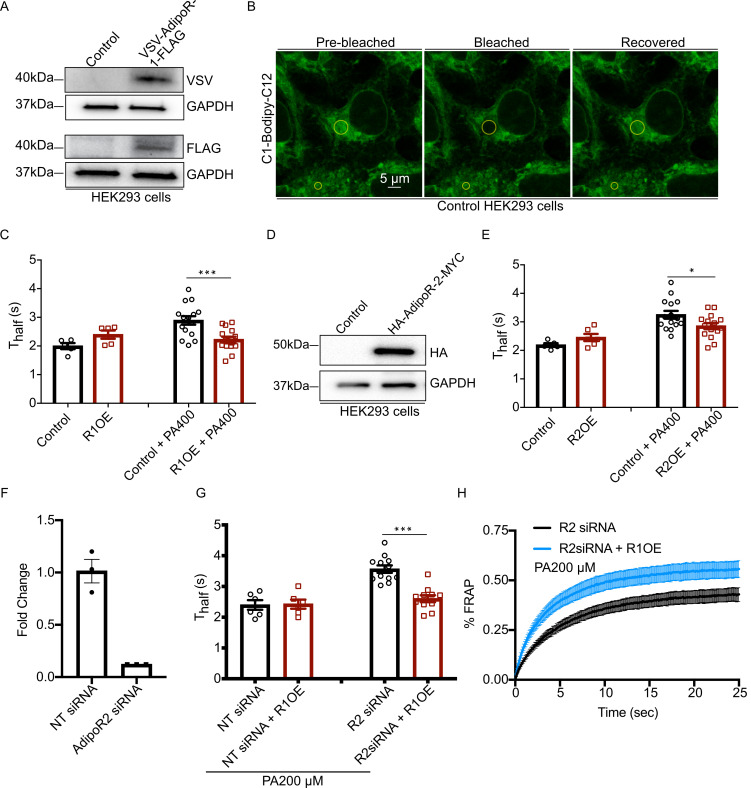
Overexpression of AdipoR1 or AdipoR2 compensates for the absence of AdipoR2 in mammalian cells.(A) Western blot detection of VSV-AdipoR1-FLAG transiently expressed in HEK293 cells, with GAPDH used as a loading control. (B) Snapshots from a typical FRAP experiment, with the bleached areas (large circle) and reference area (small circle) indicated before and after bleaching. (C) Thalf from FRAP experiments showing that the addition of 400 μM palmitic acid causes membrane rigidification and that this effect is attenuated by AdipoR1 overexpression (R1OE). (D) Western blot detection of HA-AdipoR2-MYC transiently expressed in HEK293 cells, with GAPDH used as a loading control. (E) Thalf from FRAP experiments showing that the addition of 400 μM palmitic acid causes membrane rigidification and that this effect is attenuated by AdipoR2 overexpression (R2OE). (F) Efficiency of the AdipoR2 siRNA knockdown normalized to non-target siRNA (NT siRNA) and quantified using QPCR. (G) Thalf from FRAP experiments showing that the addition of overexpression of AdipoR1 (R1OE) prevents membrane rigidification in cells where AdipoR2 has been silenced by siRNA. (H) FRAP curves for the AdipoR2 siRNA-treated samples from G; note the improved fluorescence recovery rate when AdipoR1 is overexpressed (R1OE). Significant differences are indicated where: * p<0.05 and ***p<0.001.